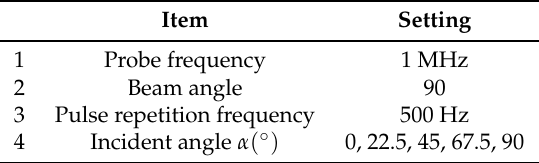
Table 1. Summary of the experimental setting of inspection device.